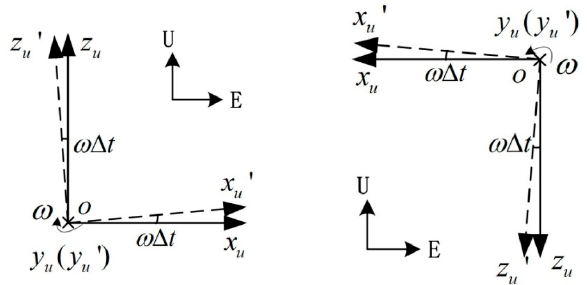
Figure 13. IMU frame at time t and t − ∆ t .